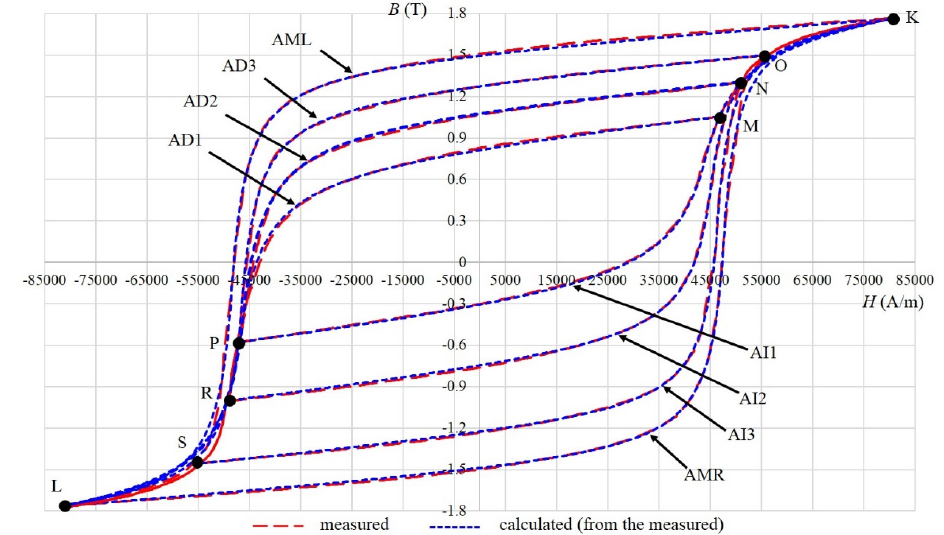
Figure 12. Measured and calculated major hysteresis loop (AML and the right part of the Alnico measured major hysteresis loop (AMR)), decreasing curves (AD1–AD3) and increasing curves (AI1– AI3).